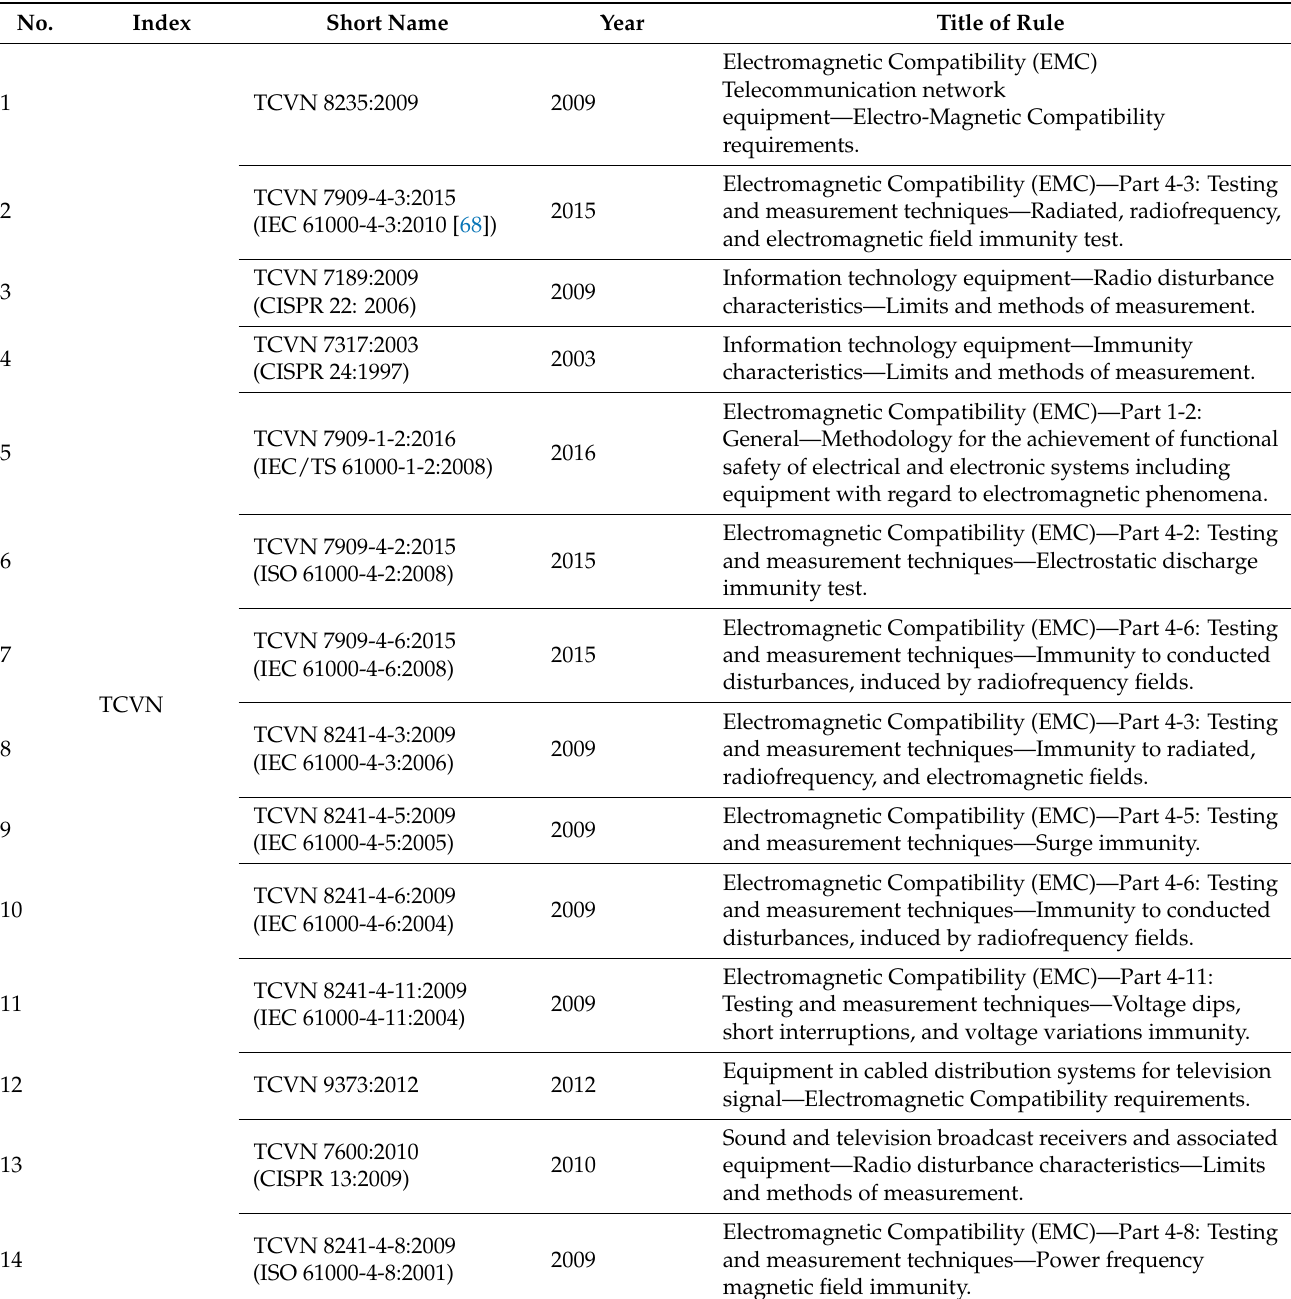
Table 2. A brief summary of the standards and regulations on electromagnetic field